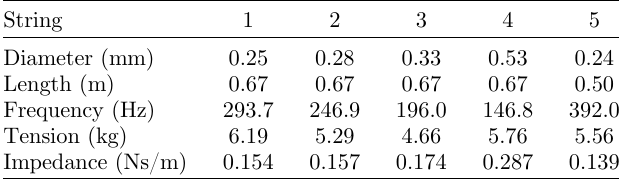
Table 2. Parameter values for the strings of the Deering